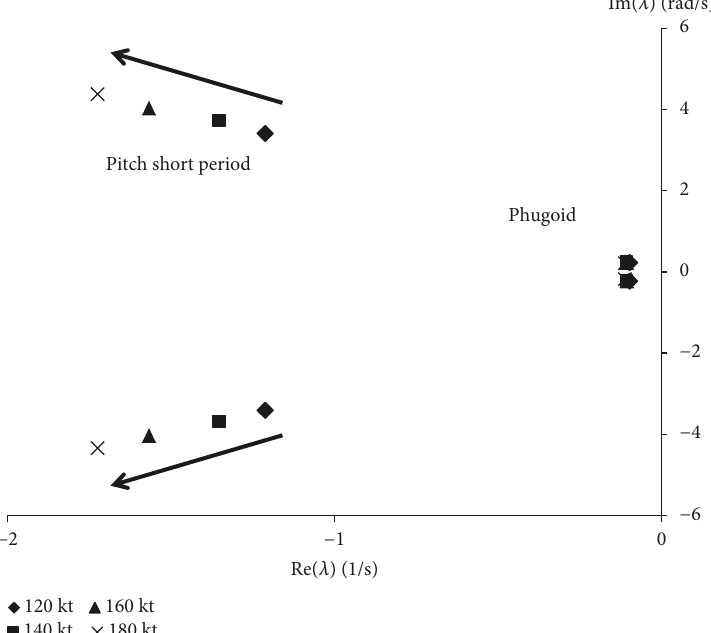
Figure 20: Longitudinal eigenvalue movement in nacelle